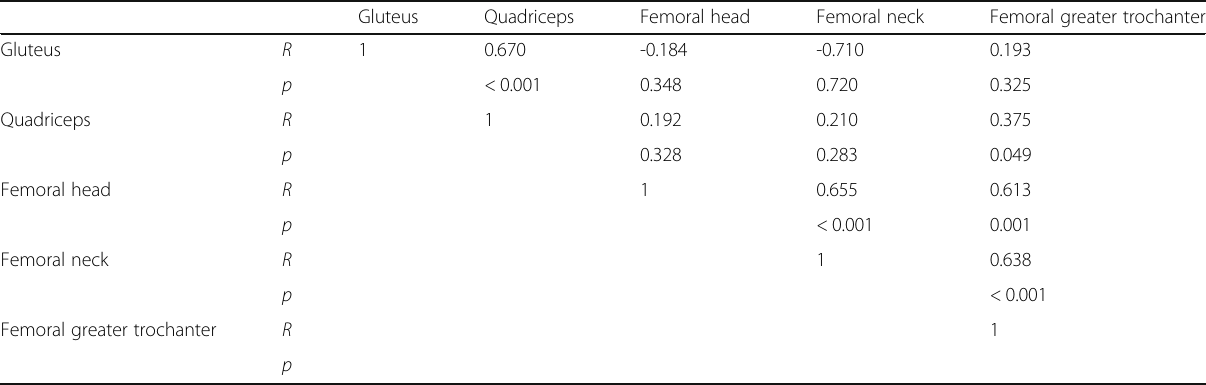
Table 2 Partial correlation analysis of proton density fat fraction of muscles and femoral subregions with age and body mass index as control